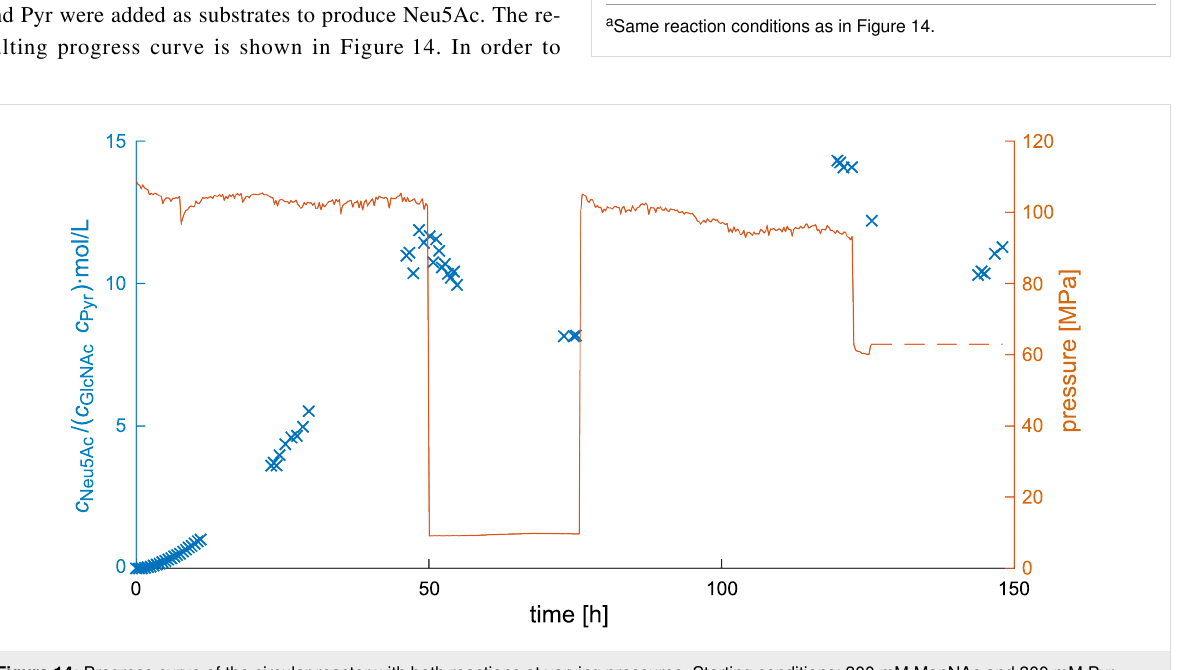
Figure 14: Progress curve of the circular reactor with both reactions at varying pressures. Starting conditions: 300 mM ManNAc and 300 mM Pyr, 100 mM potassium phosphate buffer at a pH of 7.50, 2 mL/min, total working volume: about 15 mL, 40 °C, 0.35 mL reactor volume, 1:9 (v/v) particles loaded with epimerase: particles loaded with aldolase, total mass: 85.4 mg particles.